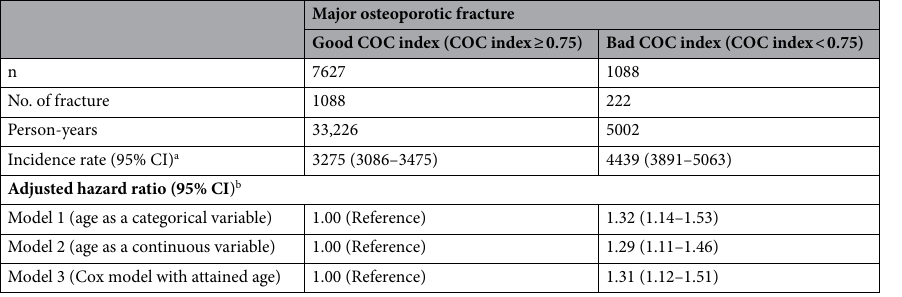
Table 3. Continuity of care and major osteoporotic fracture risk in patients with newly developed rheumatoid arthritis. Major osteoporotic fracture included fracture of lumbar spine and pelvis, forearm, or hip. COC continuity of care, CI confidence interval. a Events per 100,000 person-years. b Adjusted with all covariates shown in Table